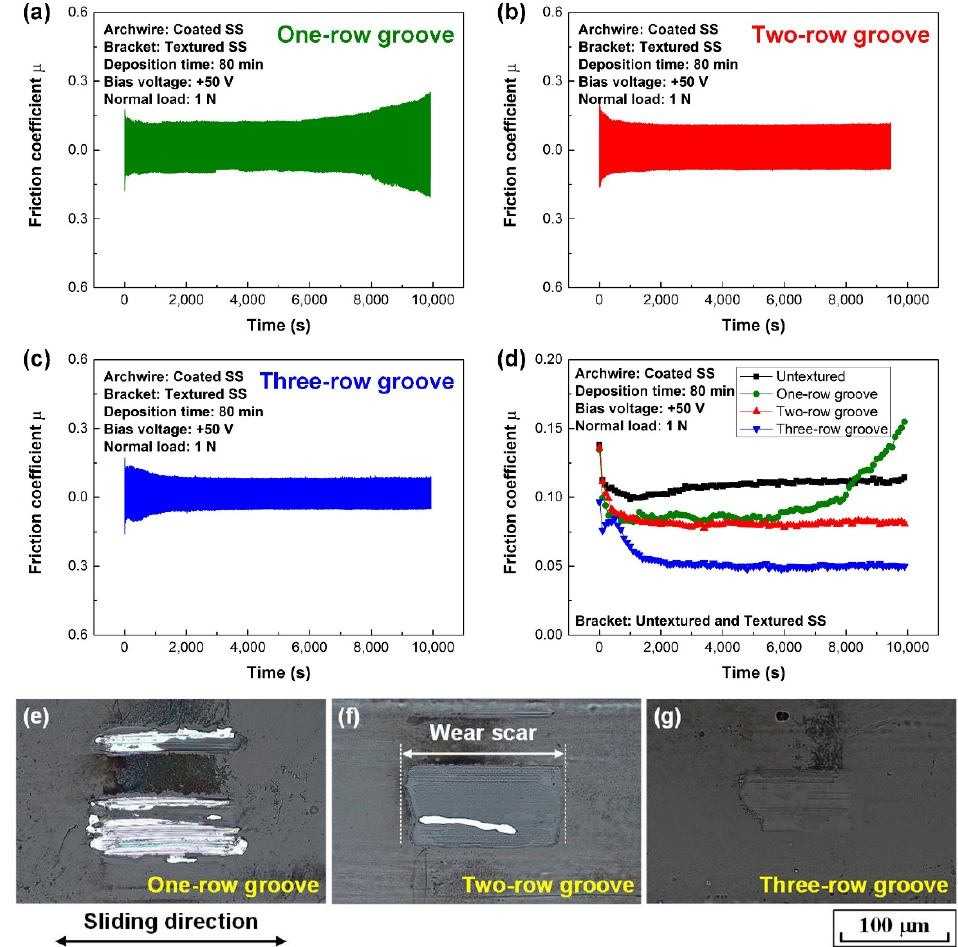
Figure 6. Fretting wear tests of carbon film (+50 V and 80 min) coated stainless steel archwires running against micro-groove textured brackets in artificial saliva environment. Friction curves of textured bracket with ( a ) one-row groove, ( b ) two-row groove, and ( c ) three-row groove. ( d ) Average friction coefficients of different textured brackets. Friction curve of untextured bracket is also shown for reference. Optical microscopy images of wear scars on the carbon films after sliding against brackets with ( e ) one-row groove, ( f ) two-row groove, and ( g ) three-row groove.